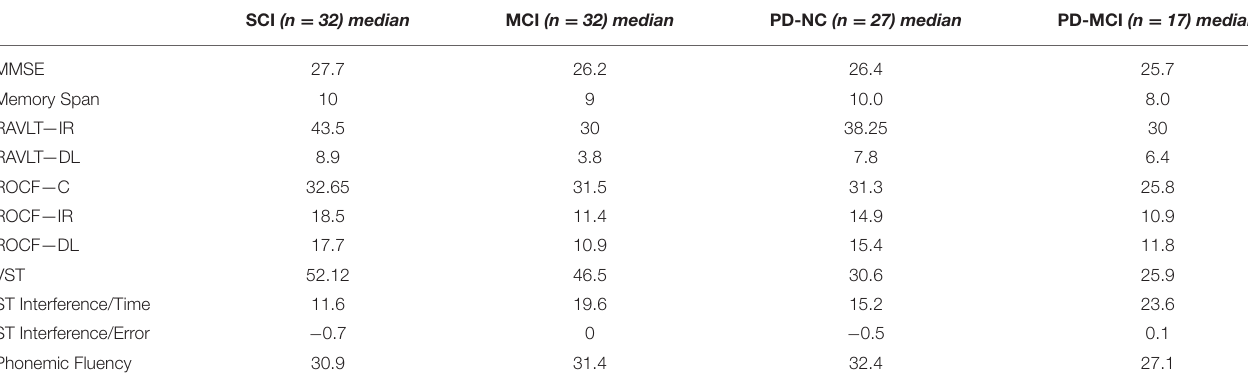
TABLE 1 | Descriptive statistics (median values) of the four groups on neuropsychological